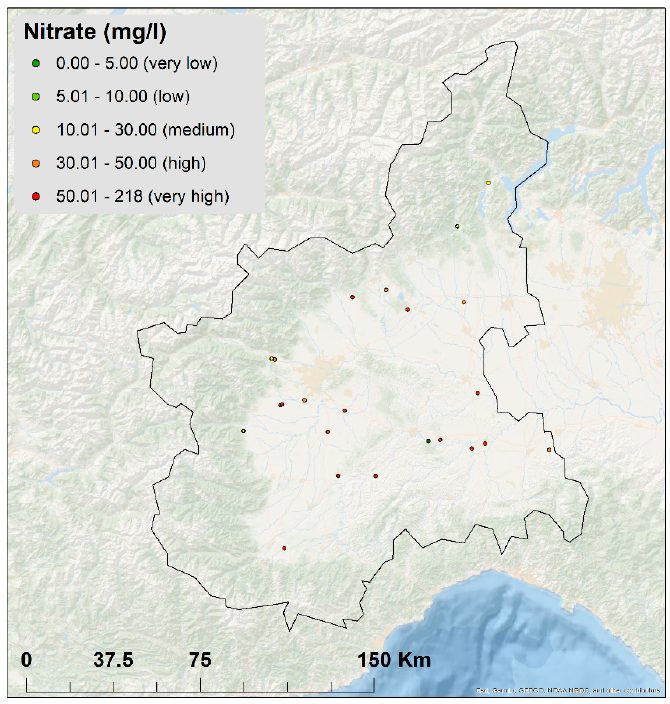
Figure 4. Distribution of nitrate (NO 3 ) monitoring points between 2005 and 2012, in the Piedmont region. Background image source: Esri, Garmin, GEBCO, NOAA NGDC, and other contributors. Source: Nistor et al. (2019).